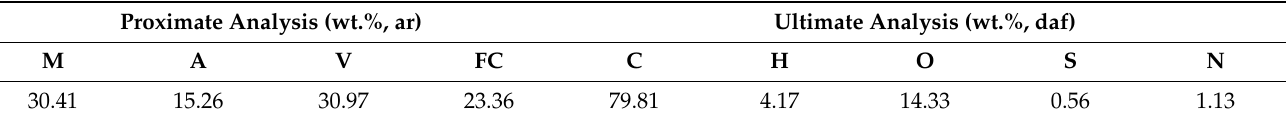
Table 1. The proximate and ultimate analysis of Hailer lignite (%). Proximate Analysis (wt.%, ar) Ultimate Analysis (wt.%,